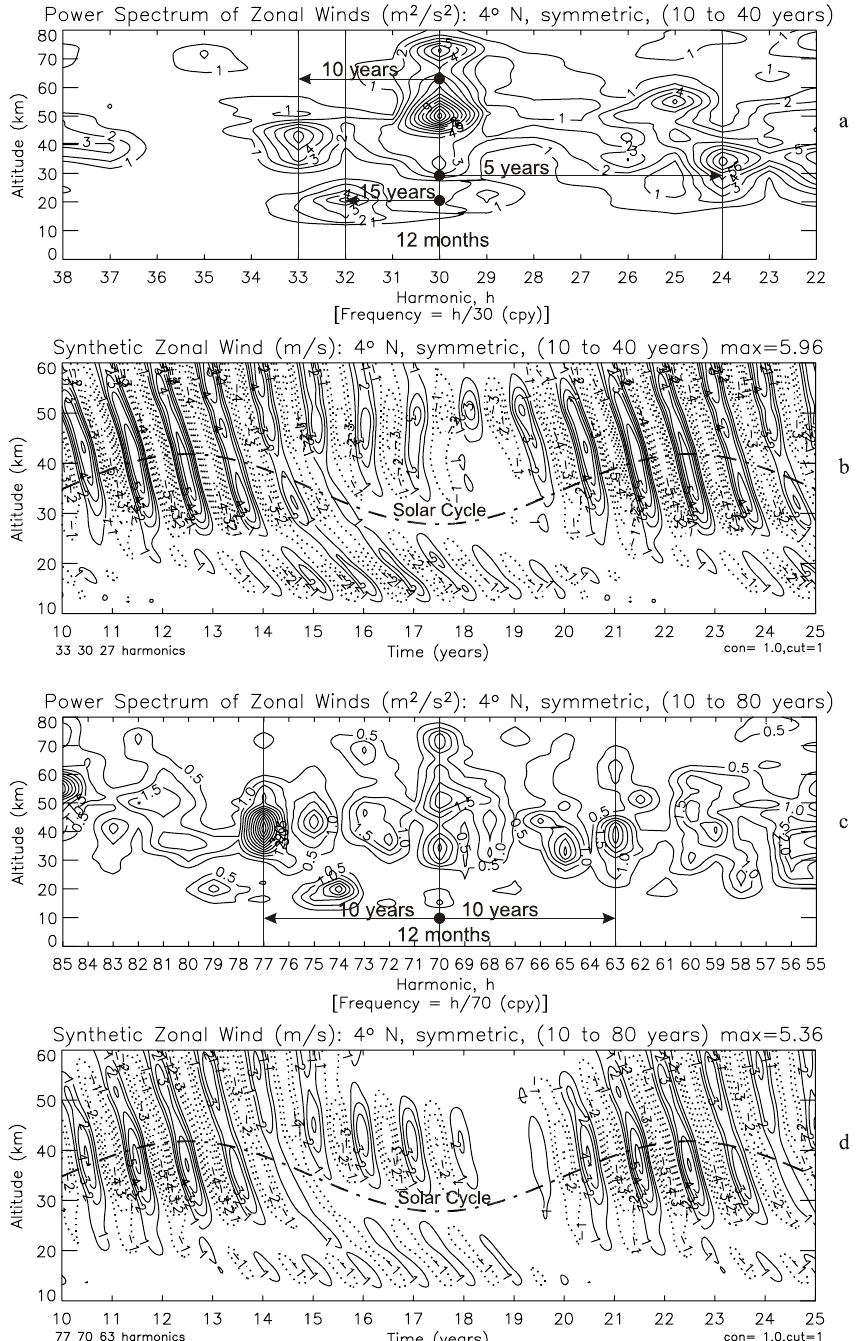
Fig. 7. (a) Similar to Fig. 4a but for the (hemispherically) symmetric 12-month annual oscillation covering the time span from 10 to 40 years (also shown in Mayr et al., 2005). For the zonal winds, the oscillation is confined to equatorial latitudes and is therefore referred to as Equatorial Annual Oscillation (EAO). The EAO is modulated by the SC, as the 10-year side lobes indicate that are identified. (b) Synthesis of the spectral features h =33, 30, 27, which describe the SC modulation. Although the magnitude of the EAO is relatively small, its SC modulation is large, and it is in phase with the imposed solar forcing. The SC modulation is also in phase with that of the QBO (Fig. 4b) to indicate that it is the pathway and pacemaker for the solar influence. (c) Similar to (a) but for the time span from 10 to 80 years. (d) The synthesized EAO shows a pattern similar to that in (b) to demonstrate that its SC modulation is a robust feature of the